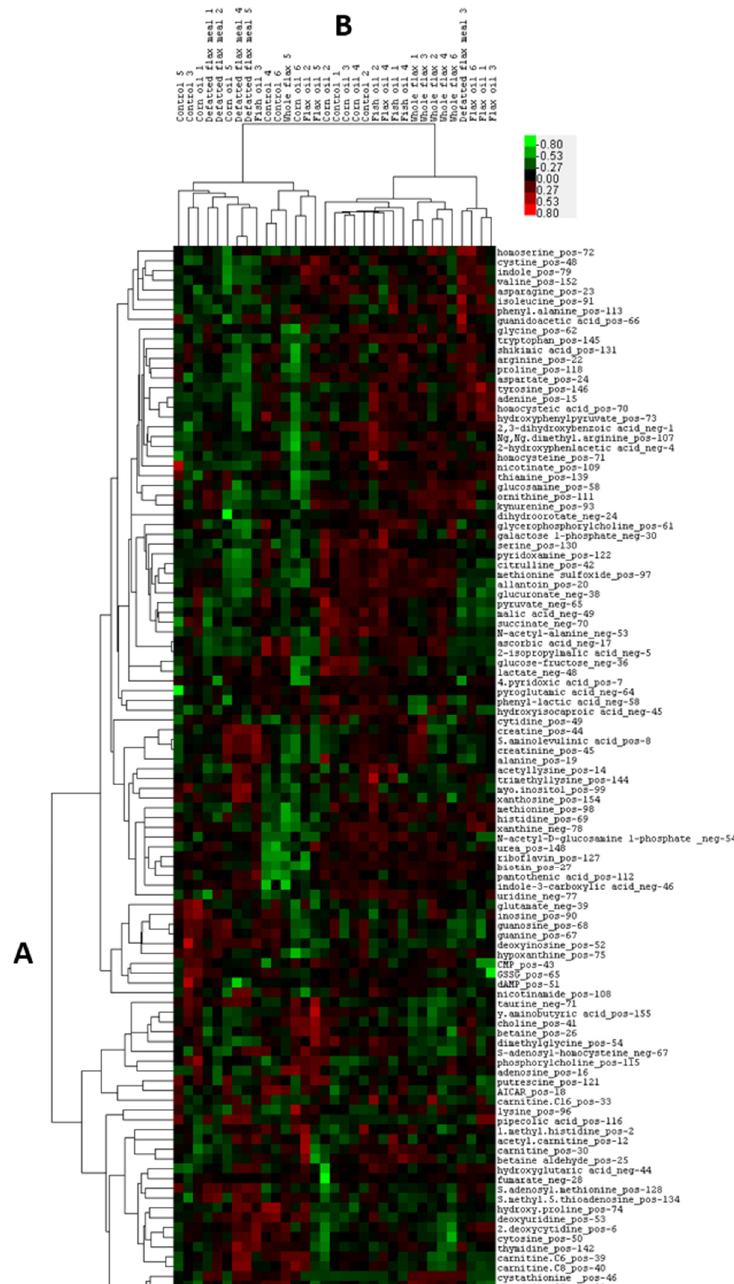
Figure 2. Heatmap illustrating grouped hierarchies of metabolites by diet group: Metabolites ( n = 108 metabolites) from hen plasma were analyzed via LC-MS/MS and organized based on the clustering of their VIP scores across diet. In dendrogram ( A ), metabolites are organized according to their similarity across diet samples. In dendrogram ( B ), diet samples are organized according to their similarity across metabolites. Green illustrates below average standard deviation, and red illustrates above average standard deviation.